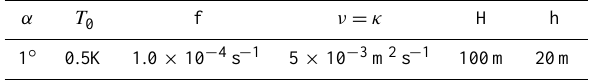
Table 1. Parameters of numerical experiment.